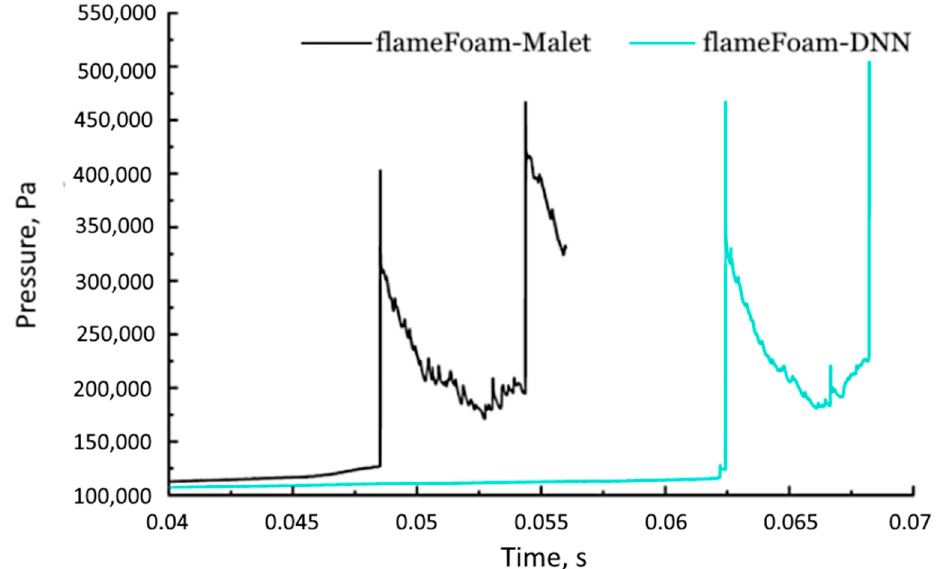
Figure 10. Pressure evolution at 6.227 m height of ENACCEF2.